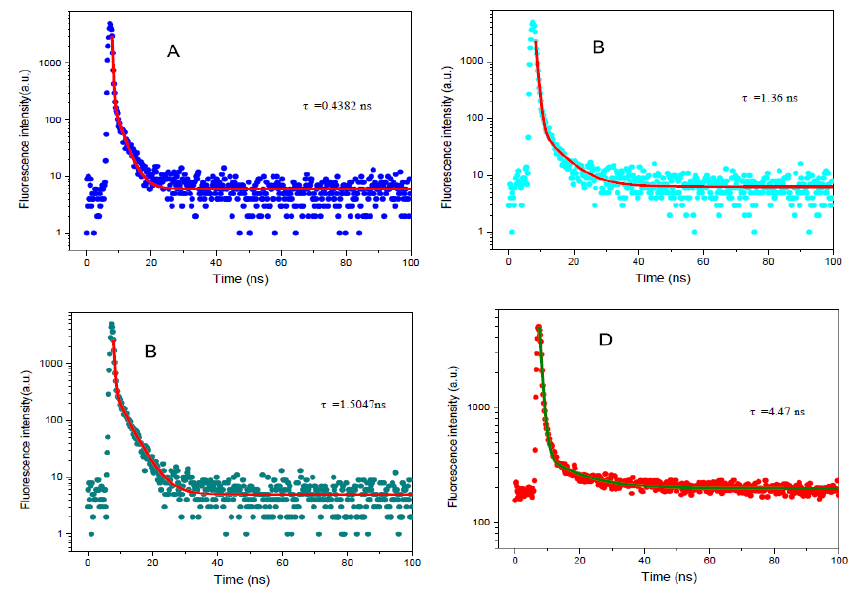
Figure 3. Time-resolved emissions of 2-APC at room temperature in dioxane ( A ), ethanol ( B ) dioxane–water ( C ) and solid-state ( D ).